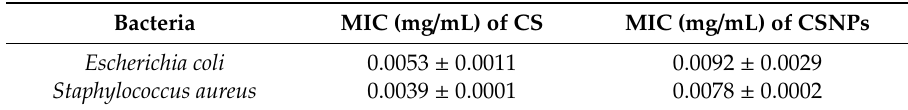
Table 4. Minimal inhibitory concentrations of chitosan solutions (CS) and dispersion of chitosan nanoparticles (CSNPs).